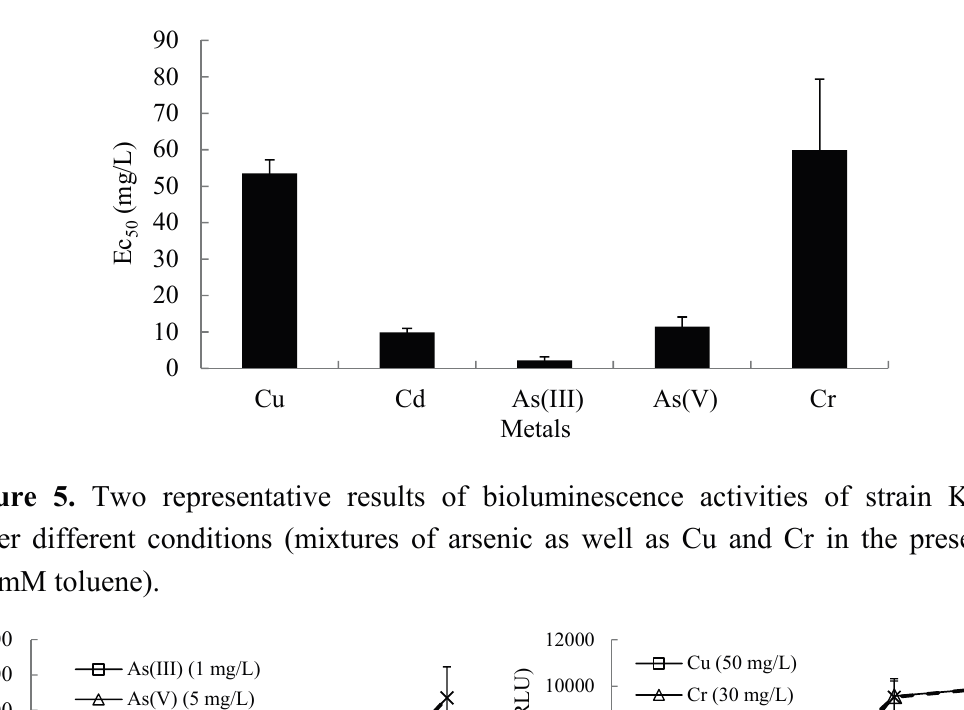
Figure 4. Summary of effects of different metals on bioluminescence induction. Each value represents average EC 50s of five inducers with same metal.